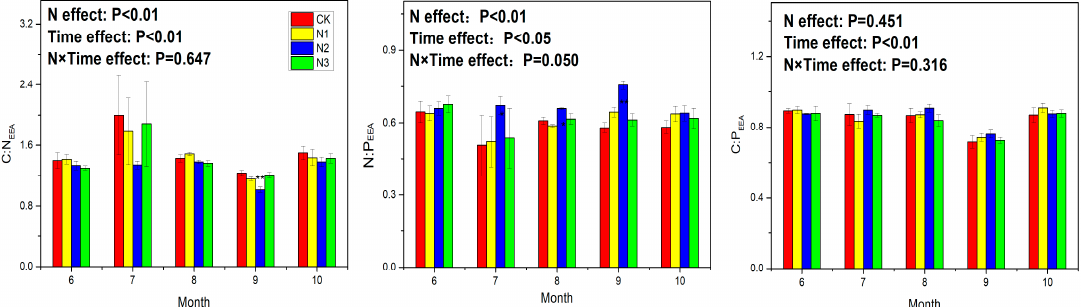
Figure 5. Response of soil enzyme activity stoichiometric ratio to N application in a subalpine coniferous forest. C:N EEA , lnBG:ln(NAG + LAP); N:P EEA , ln(NAG + LAP):lnAP; C:P EEA , lnBG:lnAP.(repeated measures ANOVA, LSD multiple comparison).